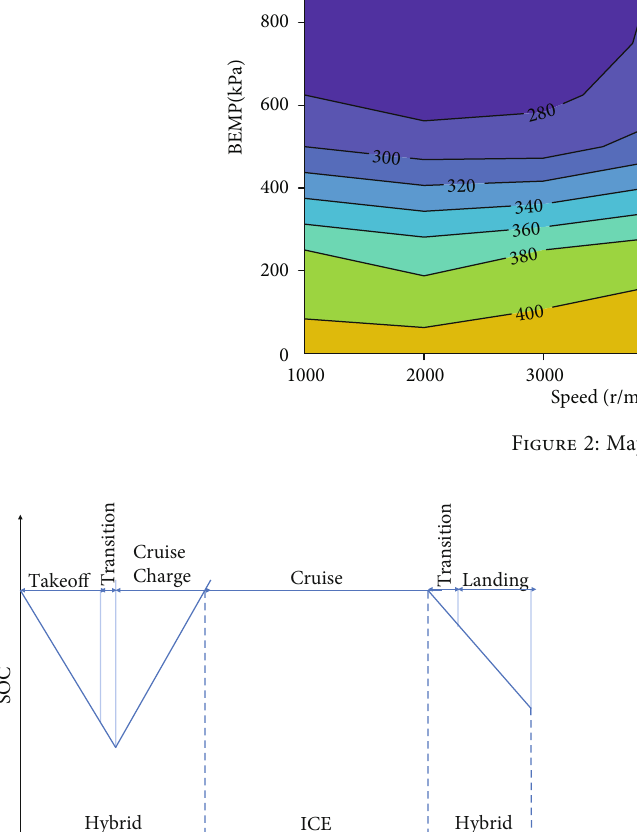
Figure 3: Power distribution diagram of the entire fl ight